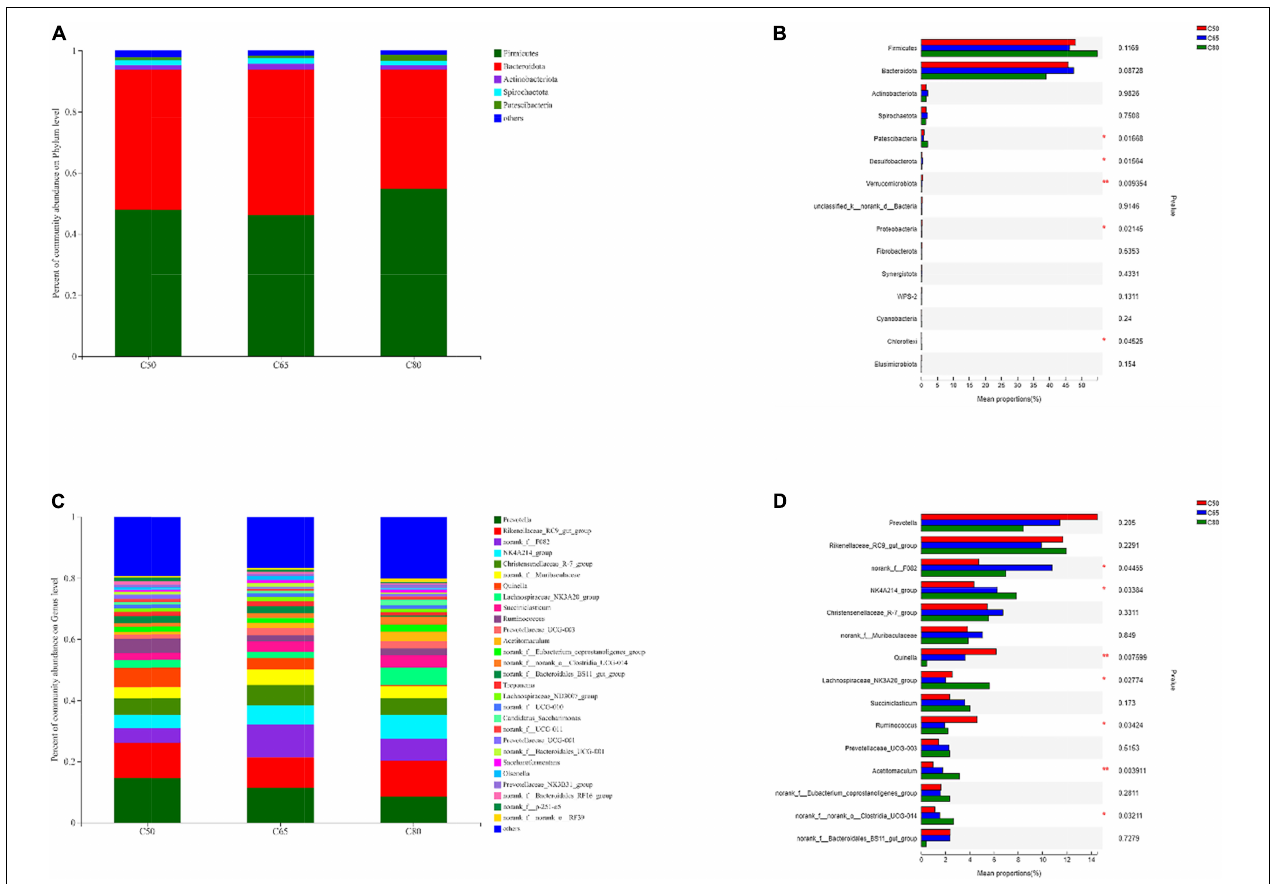
FIGURE 2 | Relative abundance of rumen bacteria at the (A,B) phylum and (C,D) genus levels in the three groups. C50, dietary concentrate-to-forage ratio 50:50; C65, dietary concentrate-to-forage ratio 65:35; C80, dietary concentrate-to-forage ratio 80:20; *0.01 < P ≤ 0.05; **0.001 < P ≤